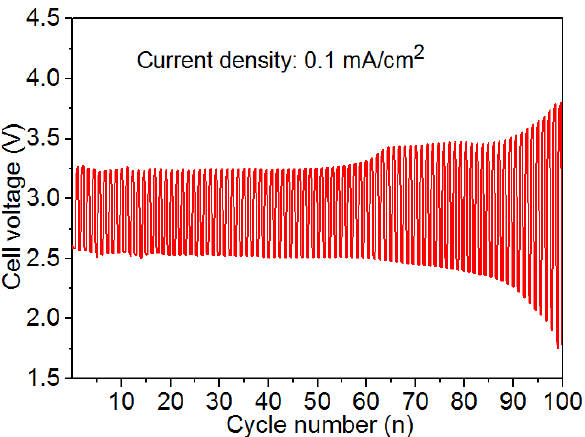
Figure 9. Cycling performance of the hybrid Na-air battery with nickel nanoparticles as catalysts during 100 cycles at a current density of 0.1 mA/cm 2 .